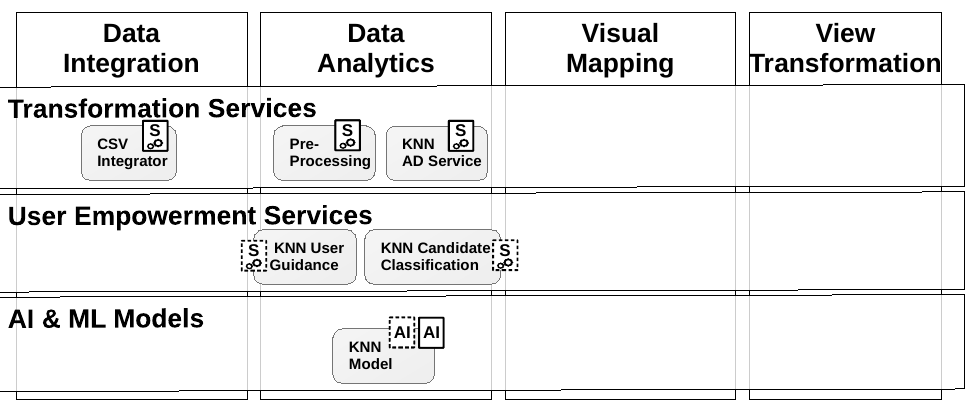
Figure 17. Implemented services and AD models categorized within the